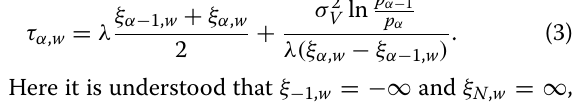
Here it is understood that ξ − 1, w = −∞ and ξ N , w = ∞ , resulting in τ 0, w = −∞ , τ N , w = ∞ . The above scheme ensures that I ( W ; S ) = 0 and that the reconstruction errors are minimised.